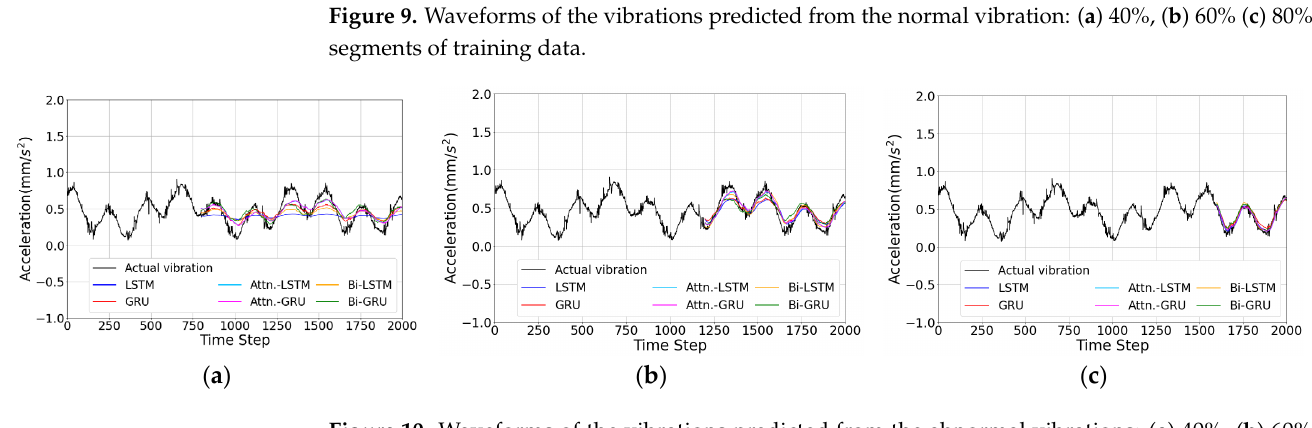
Figure 11. Scatter plots of normal vibrations: ( a ) 40%, ( b ) 60%, ( c ) 80% segment of training data .